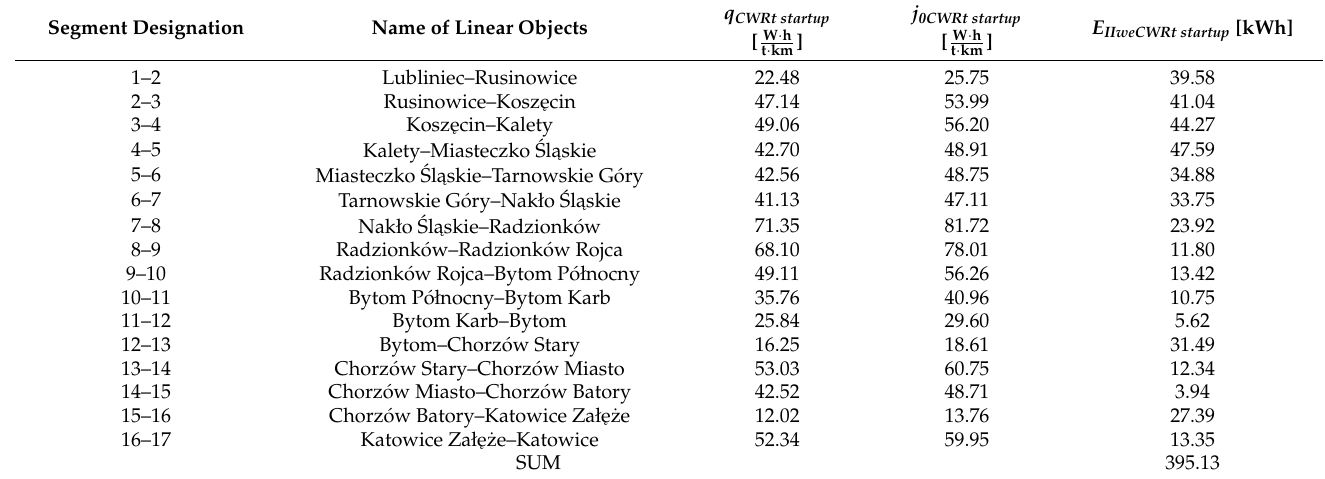
Table 6. Calculated electricity consumption values q CWRt startup , j 0CWRt startup , and E IIweCWRt startup (Variant II, the new approach during startup on continuous welded rail